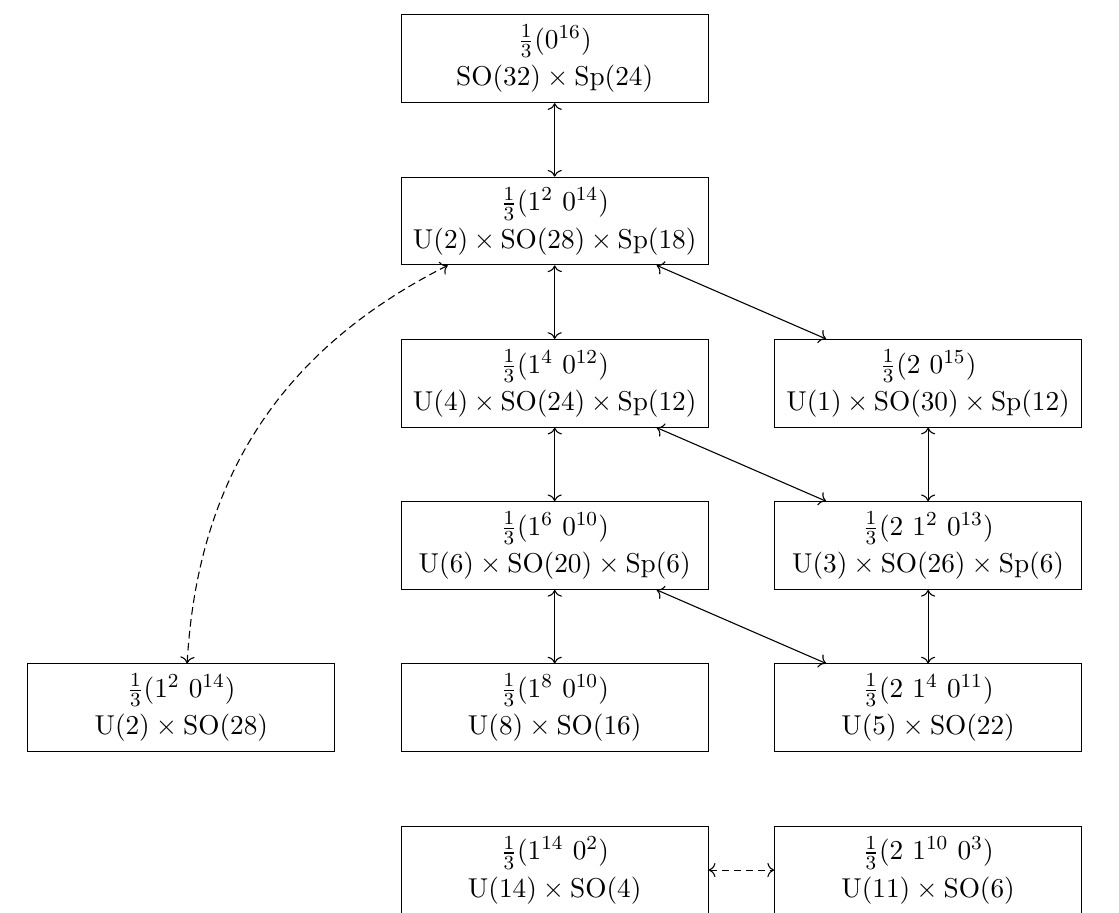
Figure 2 . Connected vacua of SO(32) heterotic string on T 4 = Z 3 orbifold. Among (cid:12)ve perturbative models, bottommost one in each column, three generate chains of connected vacua. Only the nearest transitions with (cid:1) E 0 = (cid:6) 1 is indicated by solid arrows. Transition for dashed arrows can 9 be proven using the chain of such